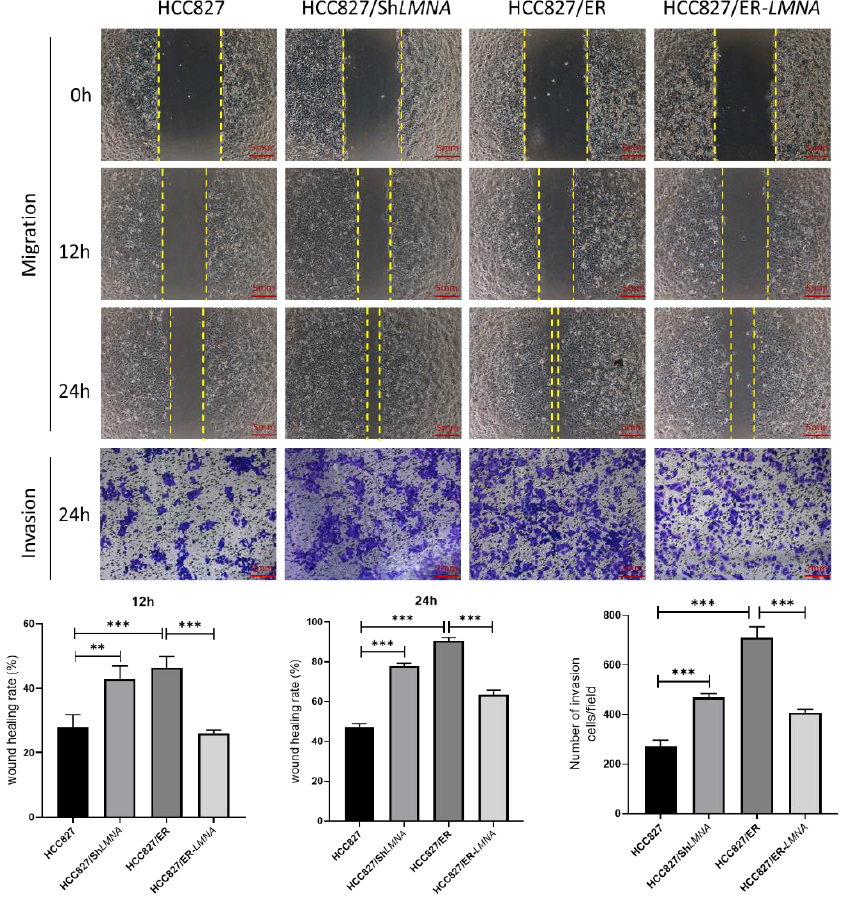
Figure 4. Effect of LMNA on the migration and invasive capabilities of HCC827 and HCC827/ER cells. Representative images show the migration and invasion ability of HCC827, HCC827/sh LMNA , HCC827/ER, and HCC827/ER- LMNA cells. Invasive cells were stained and counted under a mi- croscope. Data are presented mean ± SD from five randomly selected visual fields. Significant differences are indicated as follows: Student’s t -test, ** p < 0.01, *** p <